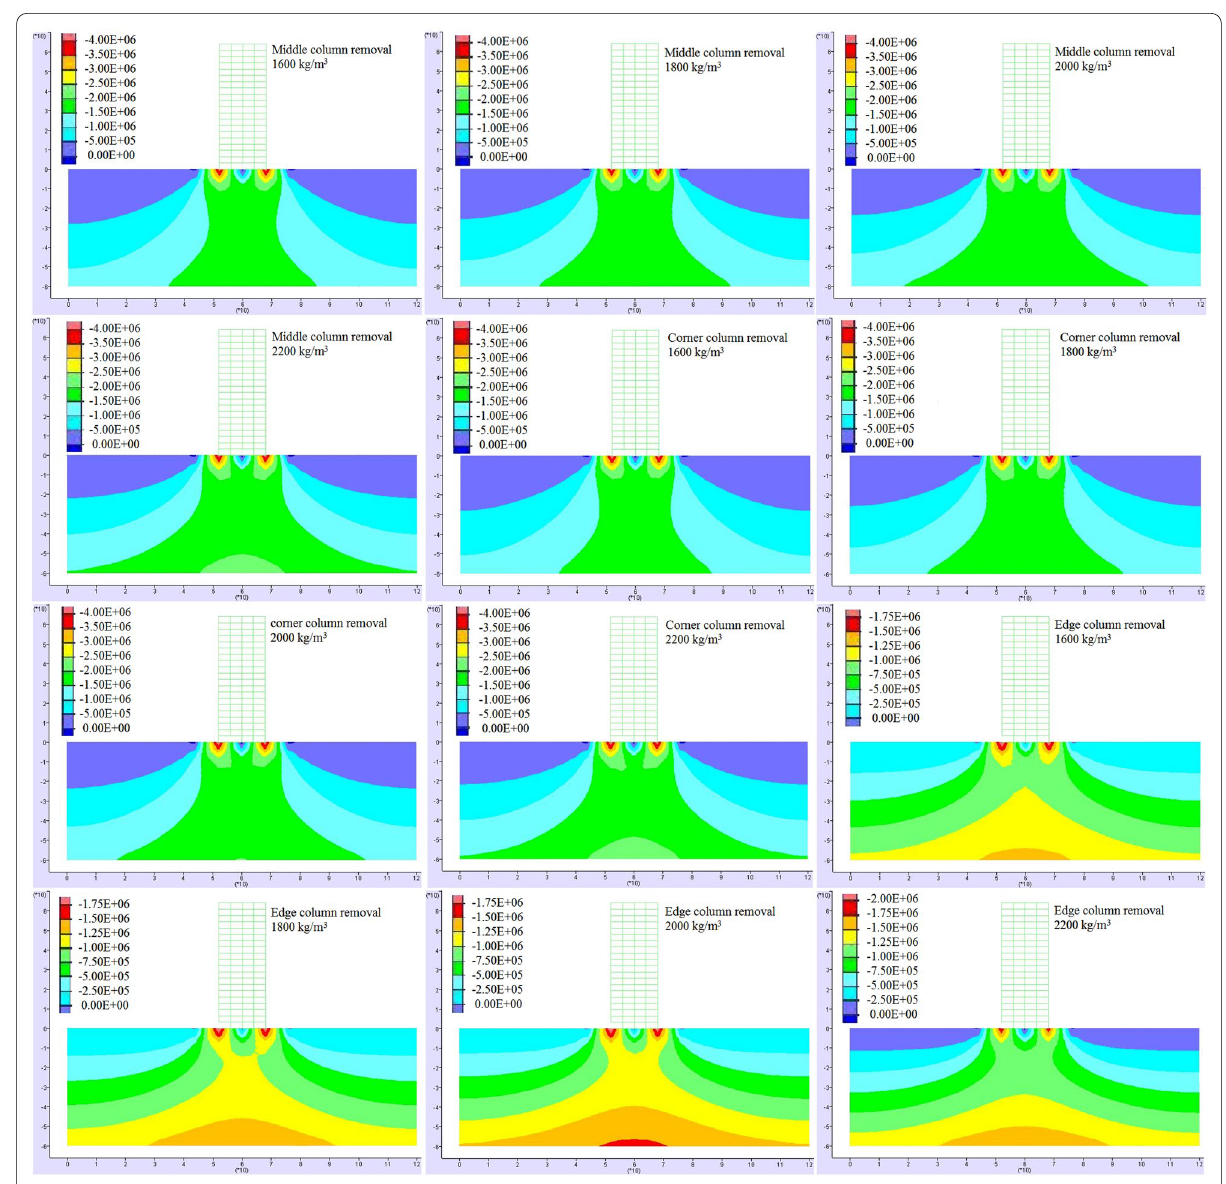
Fig. 11 SYY contours of the frames with column removal with different soil